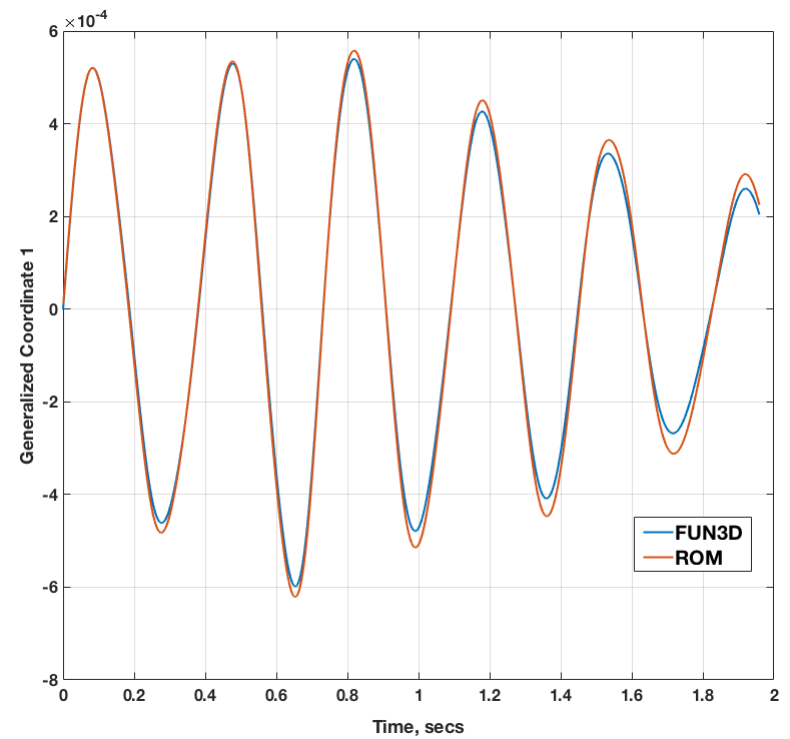
Figure 7. Comparison of full FUN3D aeroelastic response and ROM aeroelastic response for the first mode of the N+2 configuration at M = 1.7 and a dynamic pressure of 2.149 psi.